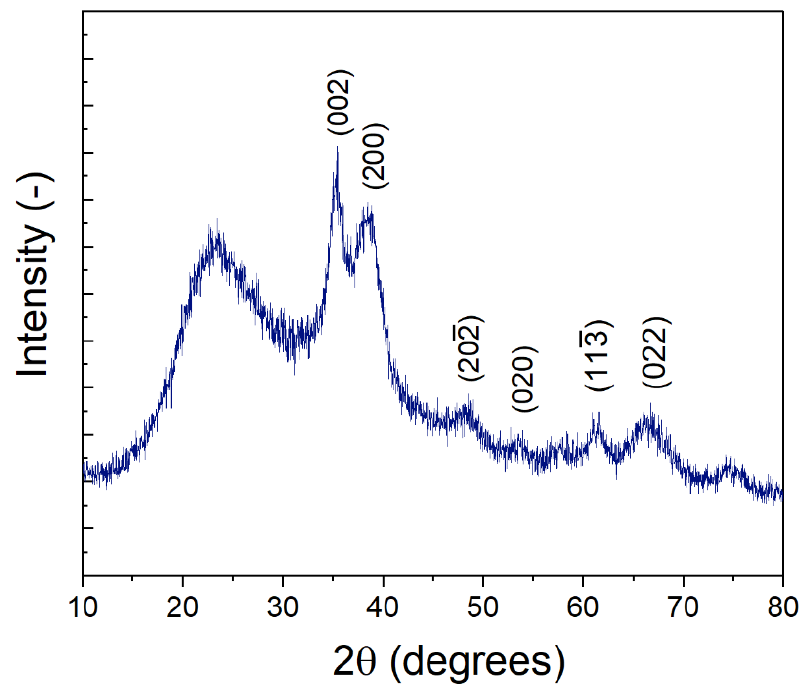
Figure 3. XRD spectra of CuO nanoparticles.